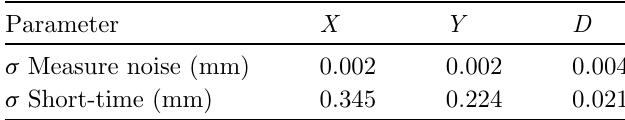
Table 1. Short time dispersions.